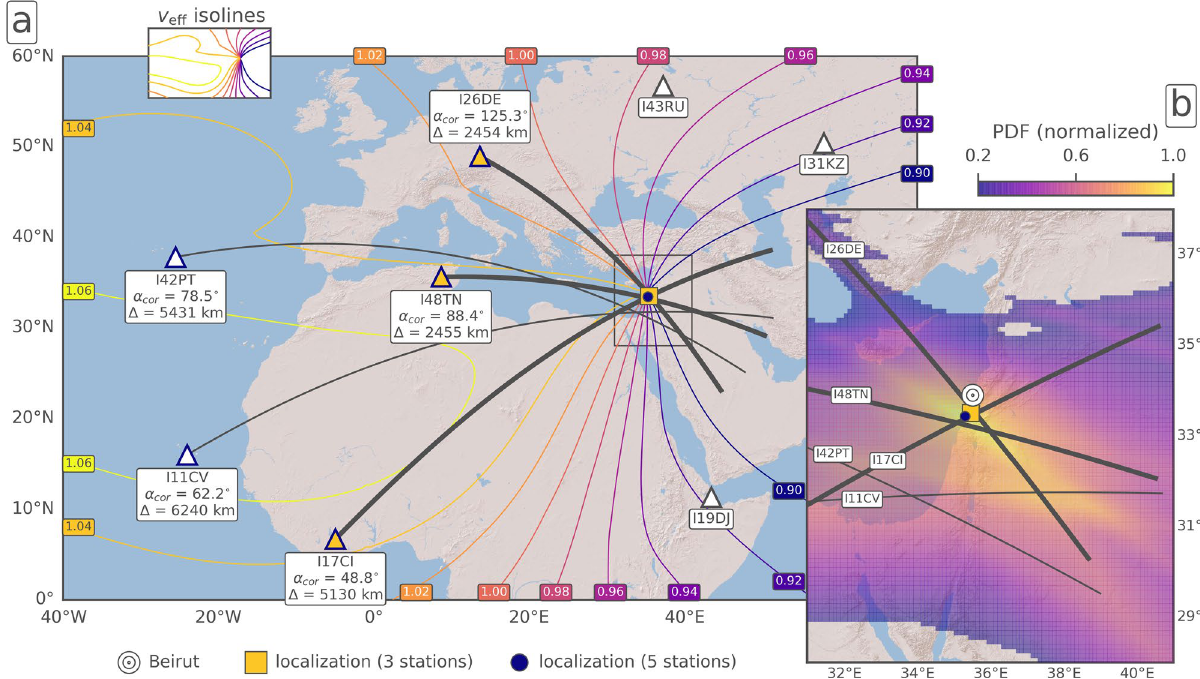
Figure 3. Localization of the explosion using IMS infrasound data. ( a ) IMS stations (triangles) and effective sound speed ratio ( v eff − ratio ) isolines respective to the source location, based on the HWM14 model for 16:00 UTC. The great-circle projections (black lines) correspond to the ECMWF-corrected PMCC back-azimuths ( α cor ) of the detecting stations. The stations with the highest signal content—given in Fig. 2 and used for yield estimation—are highlighted (yellow triangle, thick lines). IMS stations at which v eff − ratio < 0.98 did not detect the explosion due to the prevailing easterly stratospheric winds. ( b ) Details of the localization using the grid- search approach (see “Infrasound array analysis, location and yield estimation” section). The maximum of the normalized probability density function (PDF) depicts the optimum location of the grid-search approach using the five detecting stations. It results in a deviation of 56 km to the southwest (blue circle) of the actual origin (white circle). Relying on the three best-detecting stations results in a slightly improved location at 44 km to the south (yellow square) as the back-azimuth uncertainty is smaller. Maps are created using the Matplotlib Basemap Toolkit (https:// matpl otlib. org/ basem ap/, last access: 2021/02/15). Background topography is available from the Esri ArcGIS Map